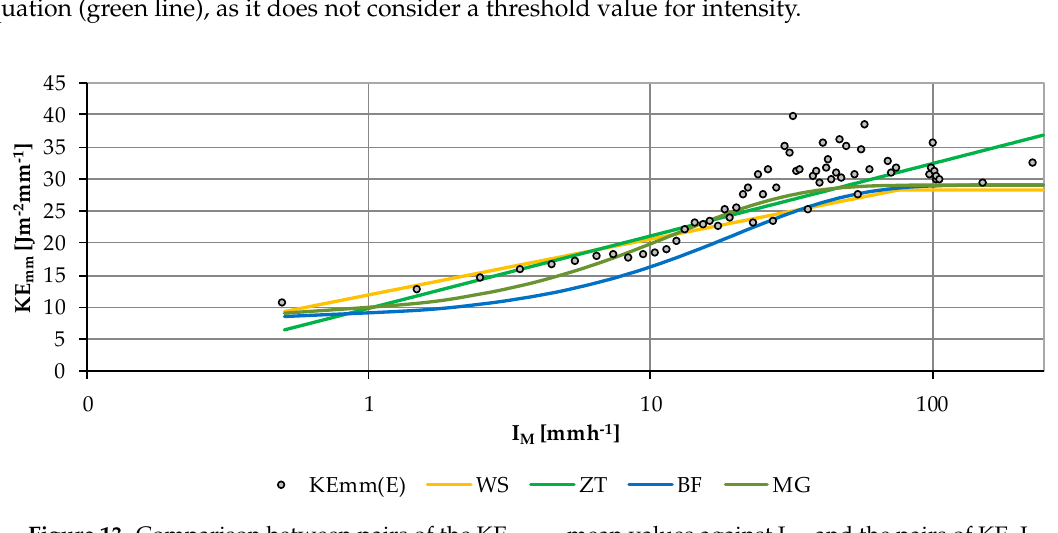
Figure 13. Comparison between pairs of the KE mm(E) mean values against I M , and the pairs of KE–I predicted by Equations (13) and (15)–(17).